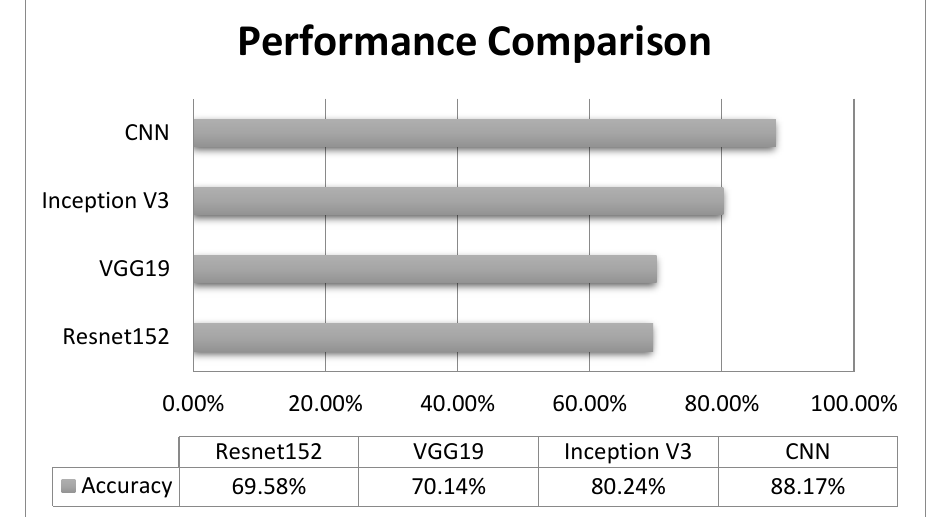
Figure 7. Comparison of transfer learning techniques with CNN.